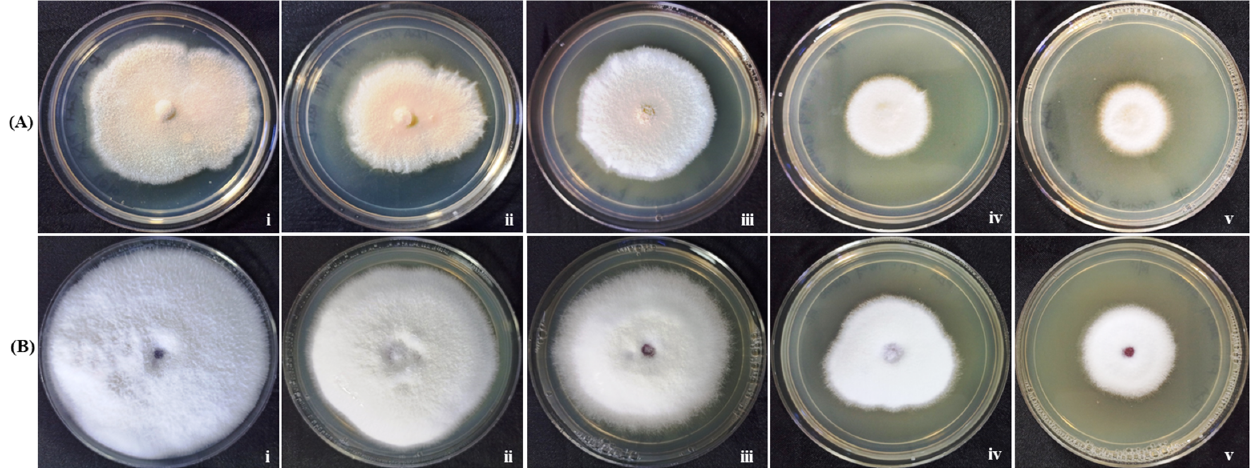
Figure 9. Antifungal activity of GNP023 s against plant pathogenic fungi, ( A ) Rhizoctonia solani and ( B ) Fusarium oxysporum . PDA plates were amended with different concentrations of GNP023 s: (i) control, (ii) 25 μ g/mL, (iii) 50 μ g/mL, (iv) 100 μ g/mL and (v) 200 μ g/mL of gold nanoparticles GNP023. Table 3. Antifungal activity of GNP023 on in vitro mycelia growth of plant pathogenic fungi. Pathogenic Fungal Strain